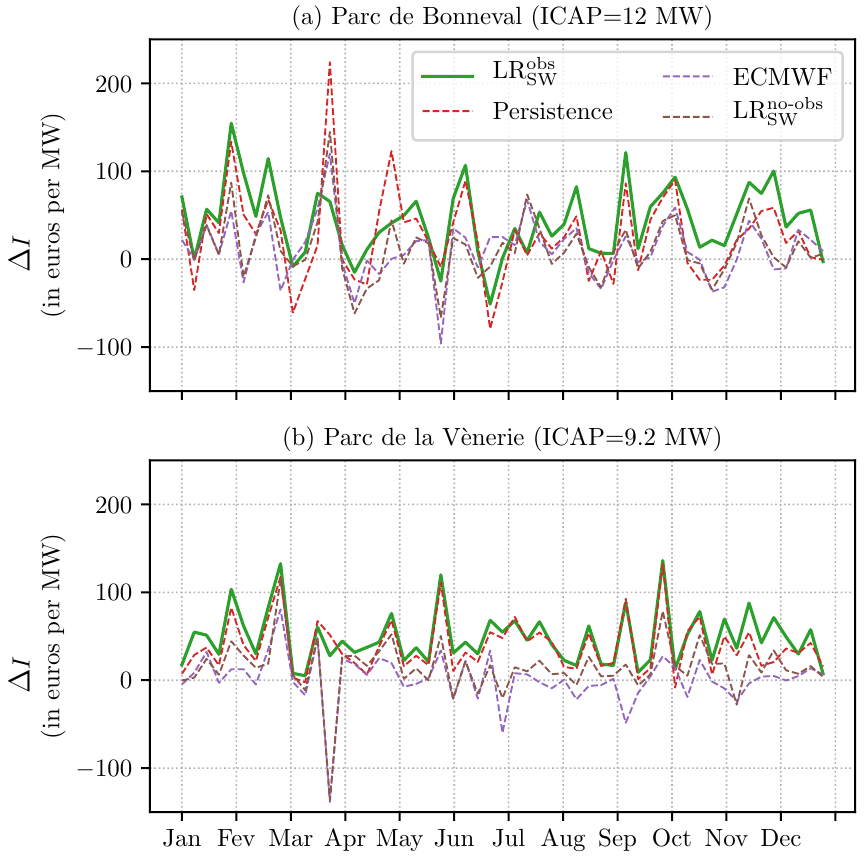
Figure 7. ∆ I (Equation (7)) normalized by the installed capacity at Parc de Bonneval ( a ) and Parc de la Vènerie ( b ). It is expressed in euros per MW and it is computed